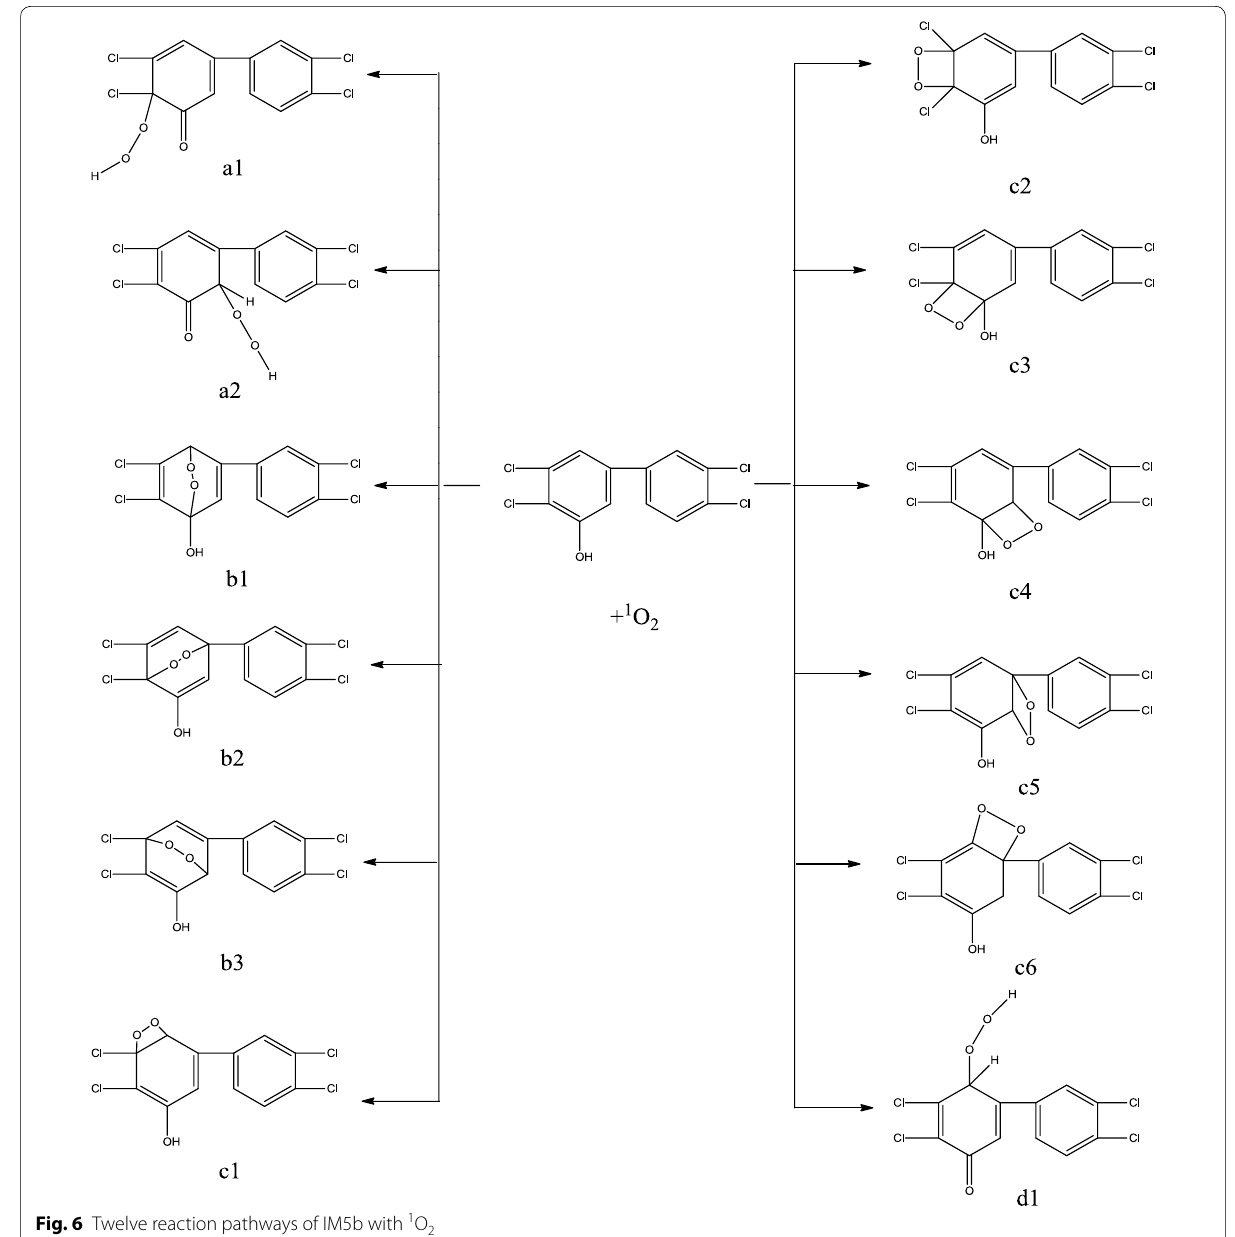
Fig. 6 Twelve reaction pathways of IM5b with 1 O 2